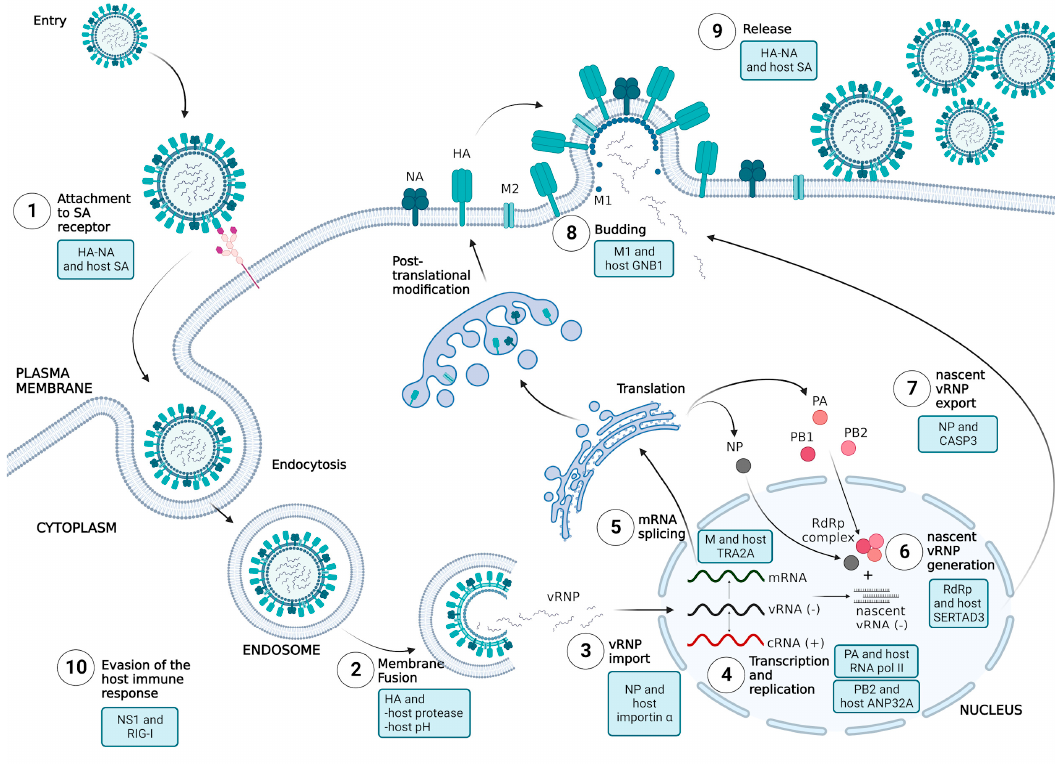
Figure 3. IAV life cycle and the key determinants of AIV tropism in the human host. (1) Upon viral entry in the respiratory tract, AIV attaches to the host sialic acid (SA) receptor by interacting with HA–NA, thus, inducing cell internalization via endocytosis. (2) The acidification of the late endosome (host pH) triggers a conformational change in cleaved HA (where HA is cleaved by host protease), which later causes membrane fusion and vRNP release into the cytoplasm. (3) Following that, vRNPs are transported into the nucleus via the host importin α / β -mediated nuclear import pathway. (4) In the nucleus, replication and transcription of viral RNA are proceeded by viral polymerases with the help of host RNA polymerase II and ANP32A. (5) After transcription, the viral mRNAs leave the nucleus to be transported to the host ribosome for translation. However, the viral pre-mRNA of M and NS undergo a maturation process in which the pre-mRNAs are spliced before the translation process. (6) In the nucleus, upon viral protein translation, NP binds to nascent viral RNA to prevent RNA degradation. PA, PB1 and PB2 are assembled as RdRp complex before binding with RNA-NP, thus, generating nascent vRNP. Then, nascent vRNPs are exported from nucleus to cytoplasm (7) and all nascent viral proteins are trafficked to the budding membrane. (8) The bud formation is initiated by the interaction of M1 with host machinery before (9) the nascent virus is released by the interaction of HA–NA with the host SA receptor. (10) Evasion of the host immune response. (Created with BioRender.com (accessed on 18 March 2023)).